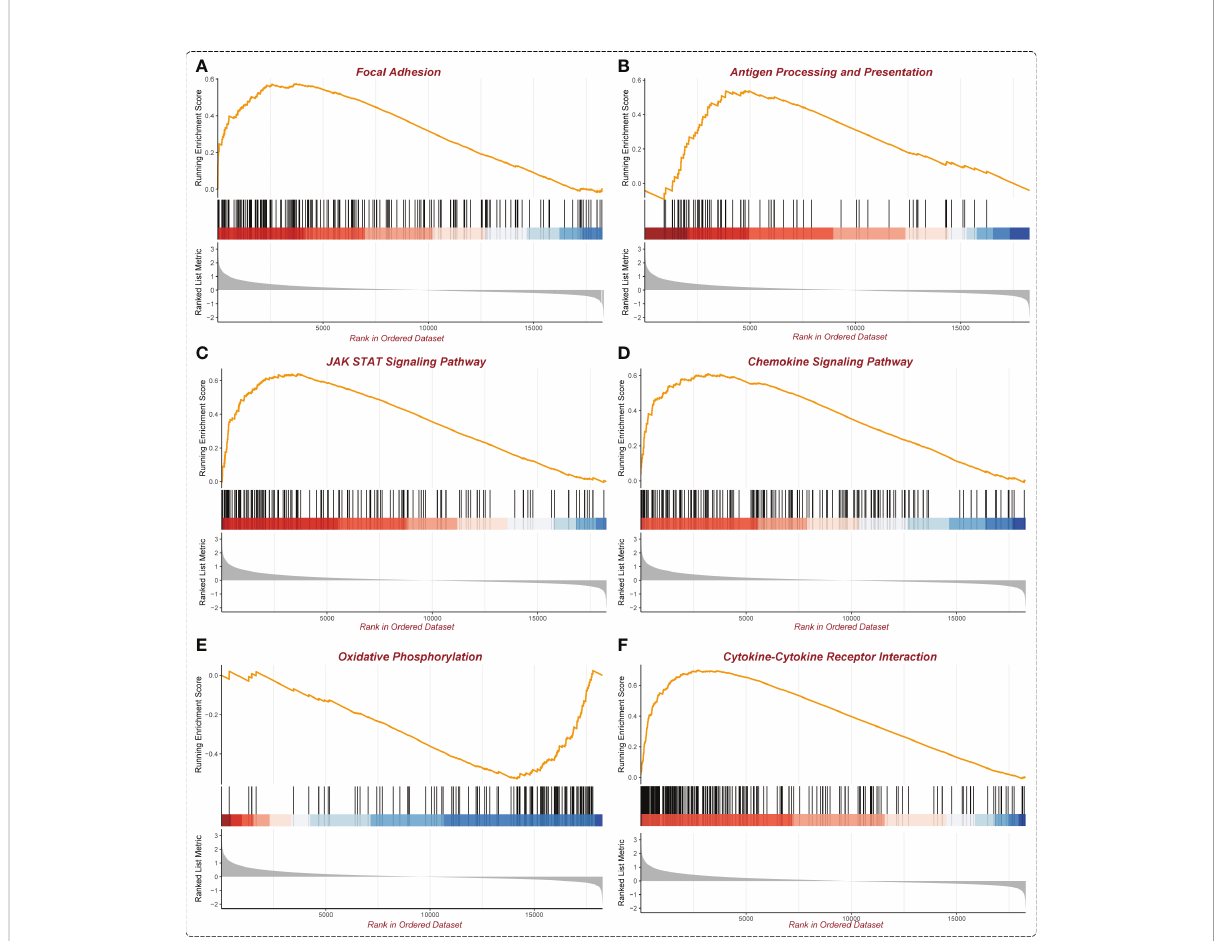
FIGURE 8 Enrichment plots from GSEA KEGG (TCGA). (A) Focal Adhesion. (B) Antigen Processing and Presentation. (C) JAK STAT Signaling Pathway. (D) Chemokine Signaling Pathway. (E) Oxidative Phosphorylation. (F) Cytokine-Cytokine Receptor